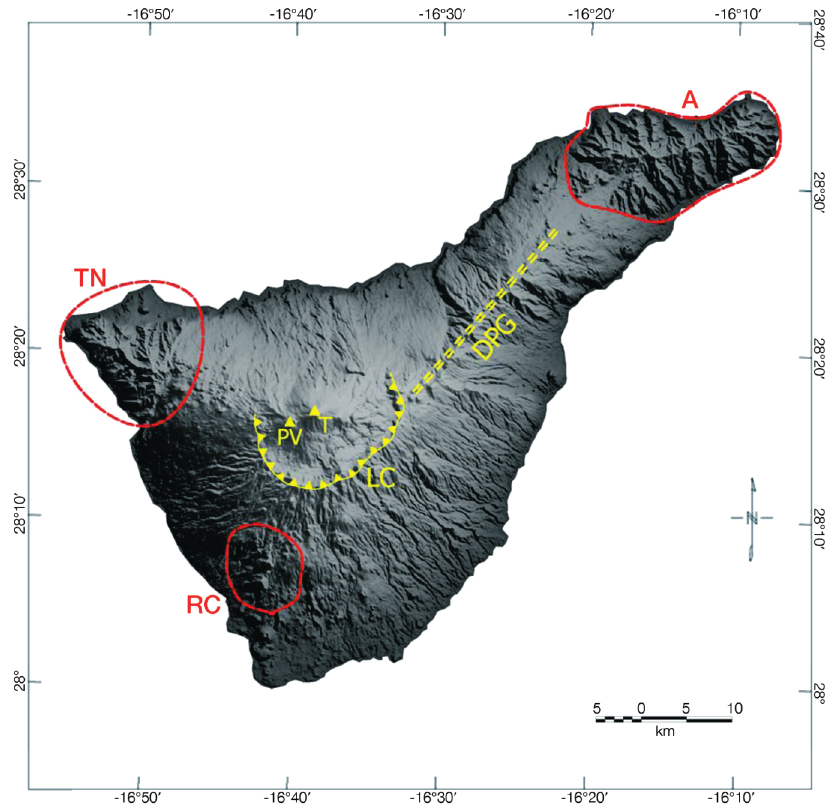
Fig. 1. Digital elevation model of Tenerife featuring the Las Cañadas caldera (LC), and the volcanic edifices of Teide (T), Pico Viejo (PV), Anaga (A), Teno (TN), Dorsal de Pedro Gil (DPG), and Roque del Conde